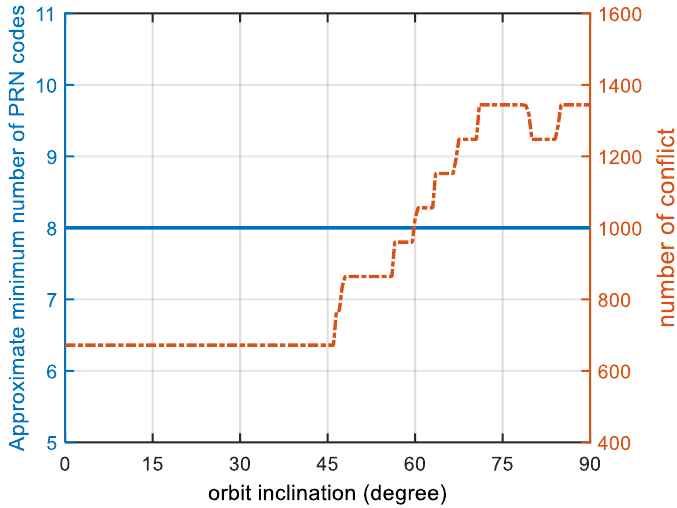
Figure 14. Graph of the orbital inclination and approximate minimum number of groups. The blue line shows the approximate minimum number of PRN codes, and the orange line shows the number of conflicts. This is a walker constellation similar to Globalstar, which is divided into 8 orbits with 11 satellites each. The orbital altitude is 1414 km. The number of conflicts is equal to the number of instances of 1 in the conflict matrix 𝑹 .